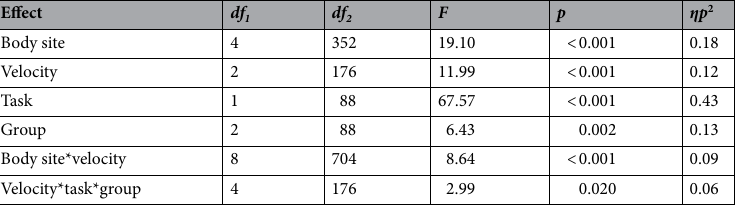
Table 3. The repeated measures ANOVA results for self-directed vs other-directed affective touch ratings, which includes the degrees of freedom, F value, p value and effect size. Each main effect and the significant 2-way and 3-way interactions are reported below. df degrees of freedom, F variance between sample means/ variation within the samples, p probability value, ηp 2 effect